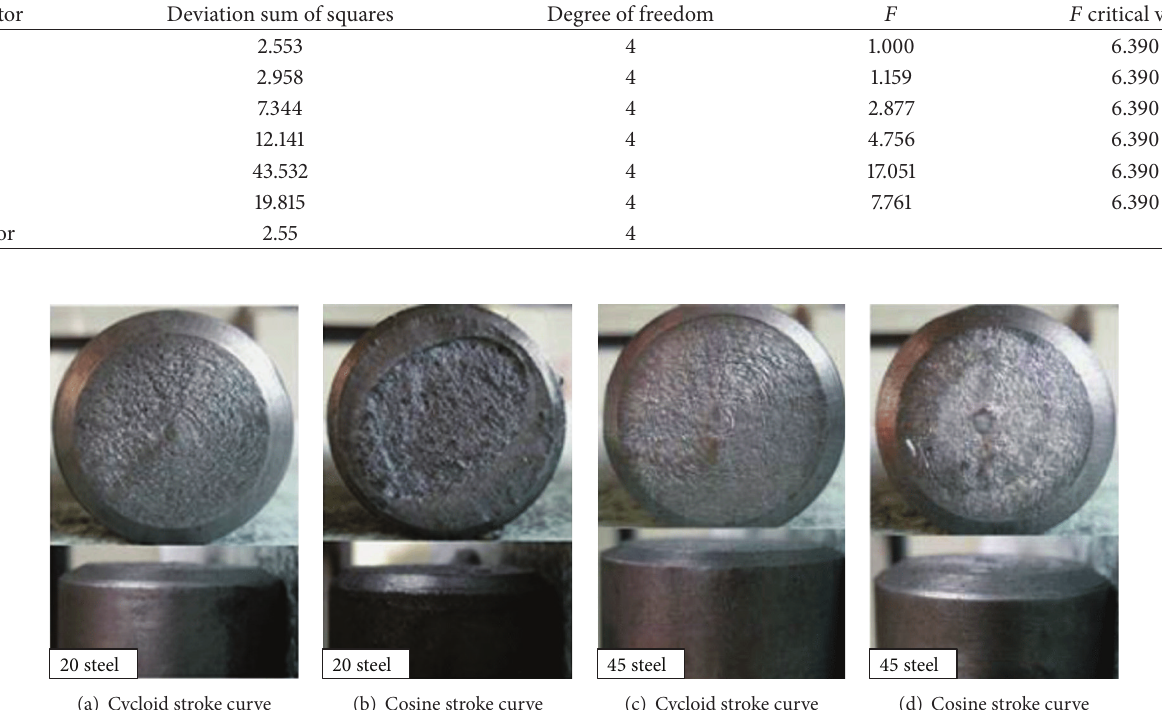
Figure 11: The cross sections for 20 steel bars and 45 steel bars in different stroke